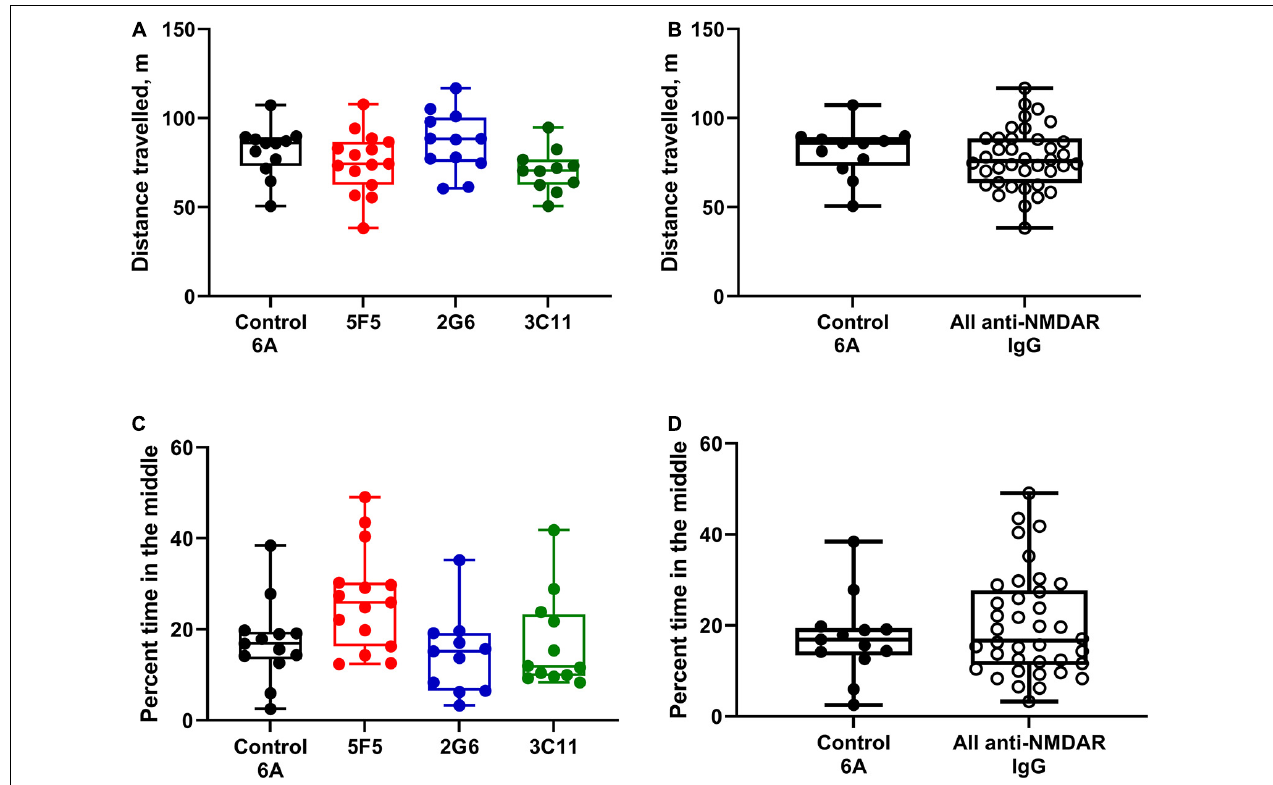
FIGURE 3 | Administration of 5F5, 2G6, or 3C11 monoclonal anti-NMDAR antibodies did not affect mouse behavior. (A) Locomotor activity was similar in mice treated with different monoclonal antibodies and control 6A IgG ( p = 0.08, ANOVA). N = 12 (control 6A IgG, black circles), n = 15 (5F5, red circles), n = 12 (2G6, blue circles), and n = 11 (3C11, green circles). (B) The distribution of total distance traveled in all anti-NMDAR antibody treated groups. (C) Despite the difference in the overall analysis, the anxiety scores in mice treated with either anti-NMDAR antibody were similar to those in control mice ( p = 0.01, ANOVA; p = 0.1 vs. 5F5; p = 0.99 vs. 2G6; p = 0.99 vs. 3C11, Tukey tests). N = 13 (control 6A IgG, black circles), n = 15 (5F5, red circles), n = 11 (2G6, blue circles) and n = 12 (3C11, green circles). (D) The distribution of cumulative anxiety scores in anti-NMDAR antibody-treated groups. Data are medians (horizontal bars), 25–75% interquartile ranges (IQR, boxes), and the minimum and maximum values (whiskers, p = 0.43, t